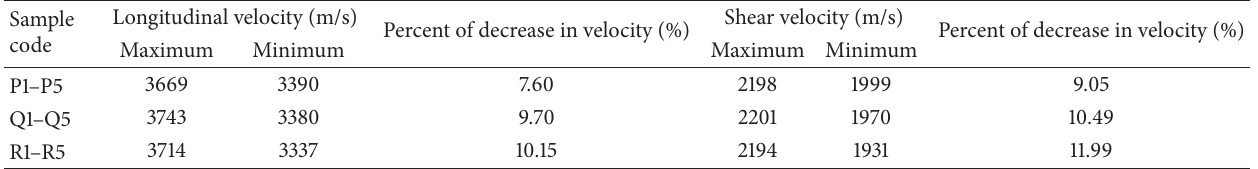
reduction in the tellurite glass network. 3